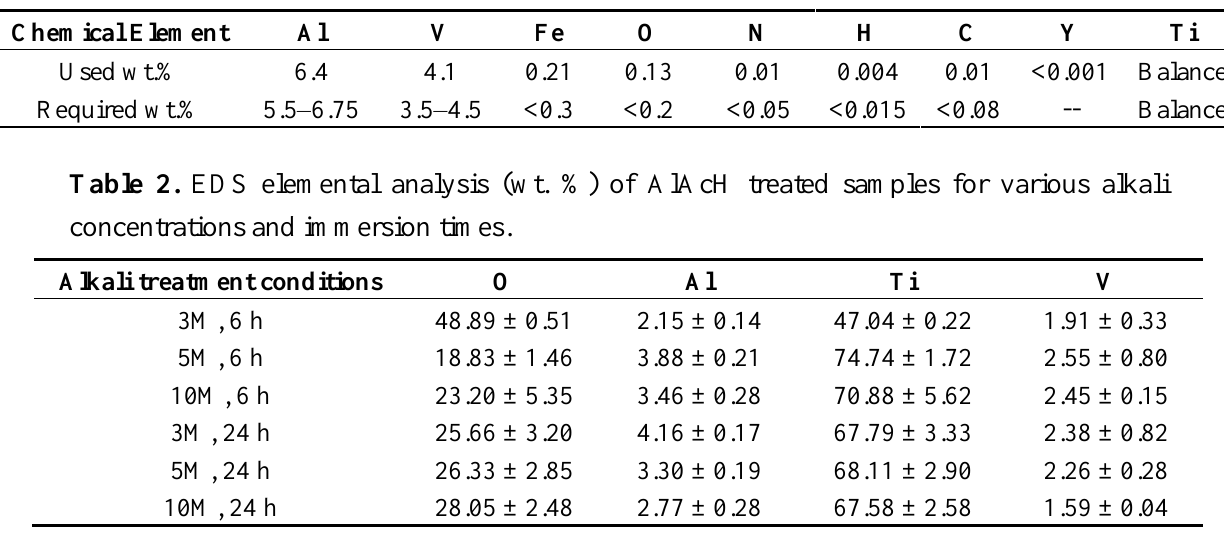
Table 1. Chemical composition of the Ti-6Al-4V pre-alloyed powder used in electron beam melting and required by DIN EN ISO 5382-3 standards.